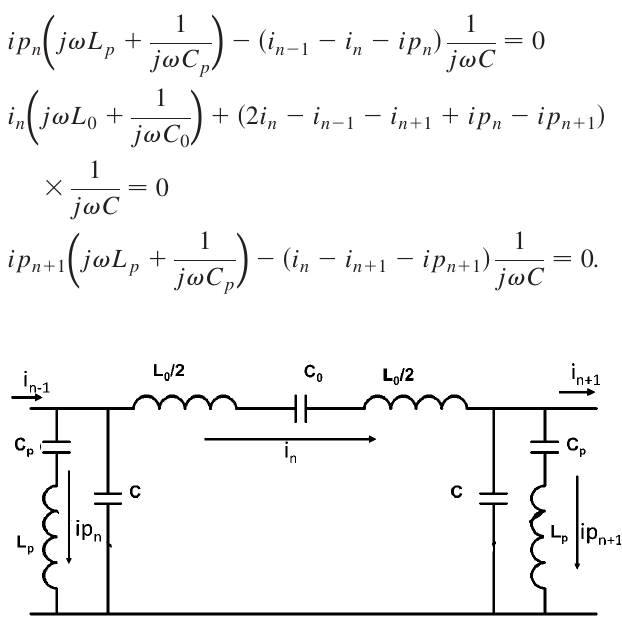
FIG. 14. Equivalent circuit for a DTL equipped with